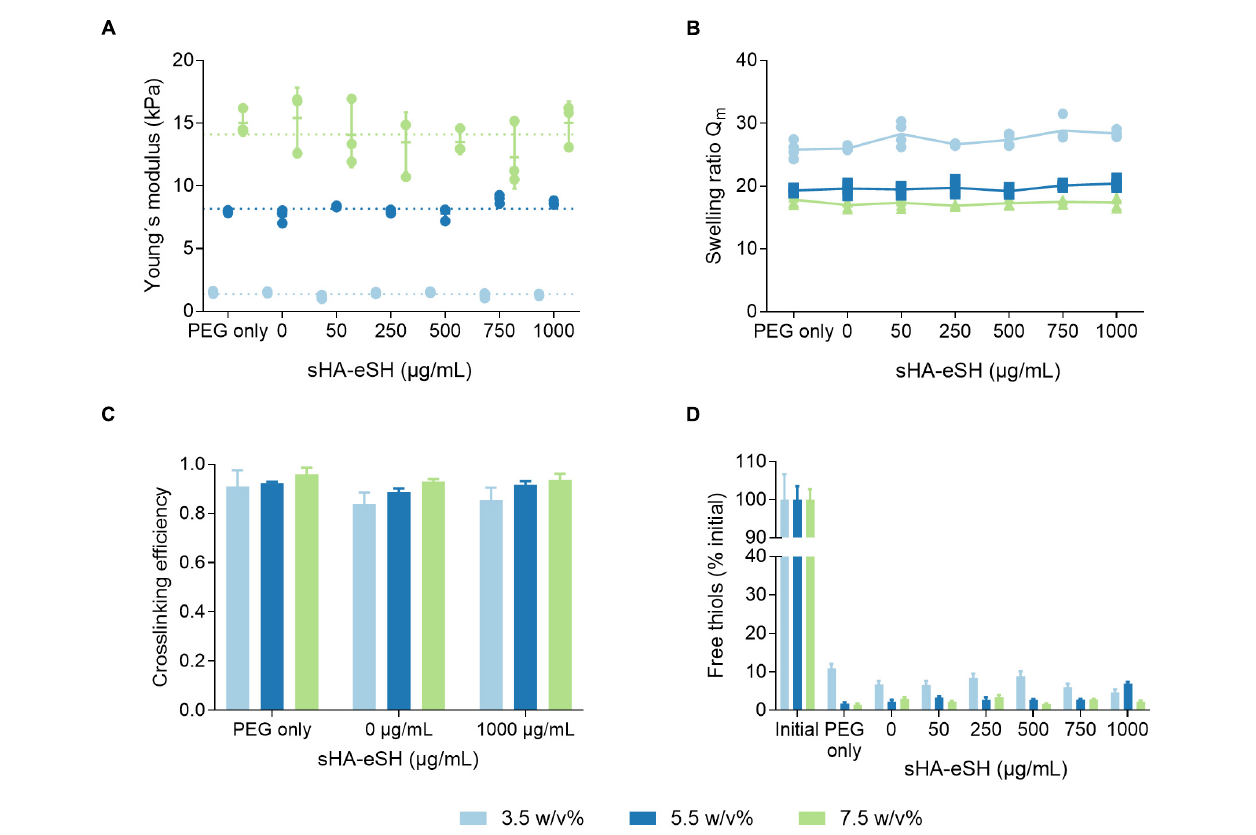
Figure 4 | Physicochemical characterization of PEG/HA hydrogels. Hydrogels were prepared in three different PEG polymer concentrations by thiol-Michael addition reaction with a PEG-dithiol crosslinker. Hydrogels were unmodified (PEG only) or functionalized with 0.5 mM linRGD and varying concentrations of sHA-eSH (0–1 mg/mL). (A) Bulk elasticity. The Young’s moduli of hydrogels were determined by shear rheological measurements and range from 1.4 to 14.1 kPa, dependent on the PEG polymer concentration; mean and standard deviation of triplicates are presented. (B) Swelling ratios. Hydrogels were equilibrium-swollen in PBS; mean and standard deviation of quadruplicates are presented. (C) Crosslinking efficiency based on the sol-gel fraction of PEG/HA hydrogels; mean and standard deviation of triplicates are presented. (D) Detection of free thiol groups within non-degradable hydrogels using Ellman’s reagent. Initial corresponds to an unpolymerized hydrogel (all thiol groups free); mean and standard deviation of triplicates are